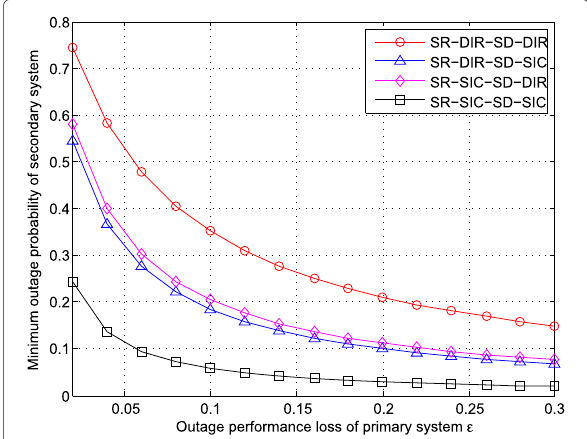
Fig. 10 Minimum outage probability of secondary system vs the outage performance loss